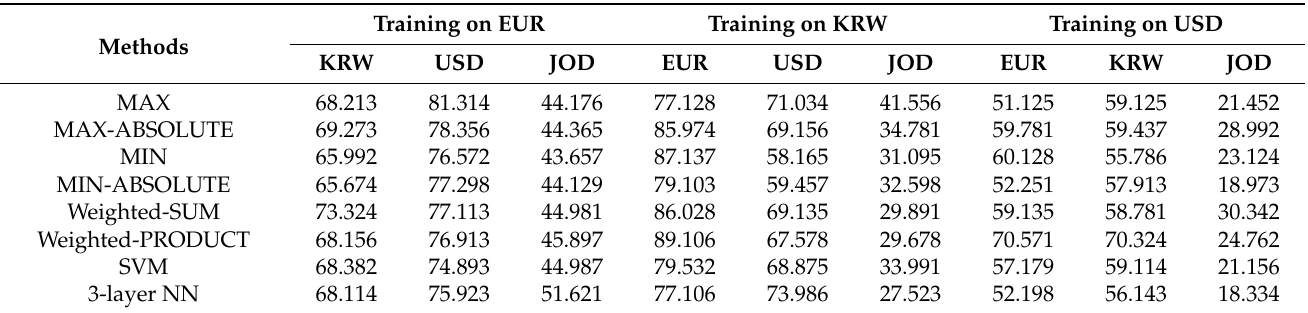
Table 9. Experimental results of training on EUR, KRW, and USD, and testing on the other currency types using the proposed fusion methods on two additional CNN classifiers. (Measure: average classification accuracy, unit: %).